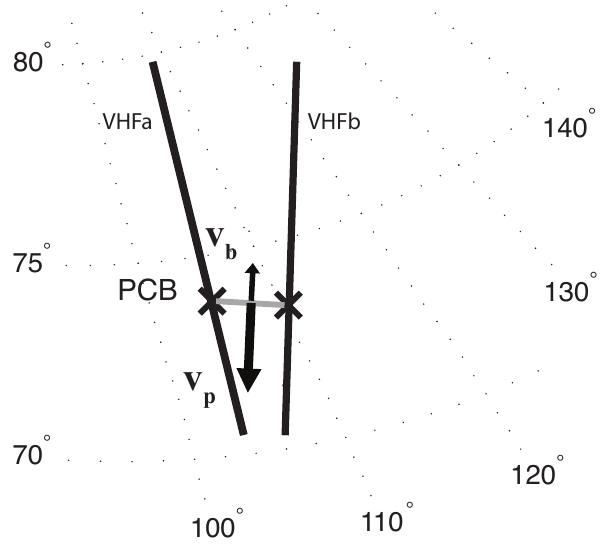
Fig. 2. Schematic presentation of the measurement. The black crosses show the PCB for the two VHF beams and the solid grey line the orientation of the PCB. Vectors v b and v p are the veloci- ties of the polar cap boundary and plasma along the PCB normal, respectively.